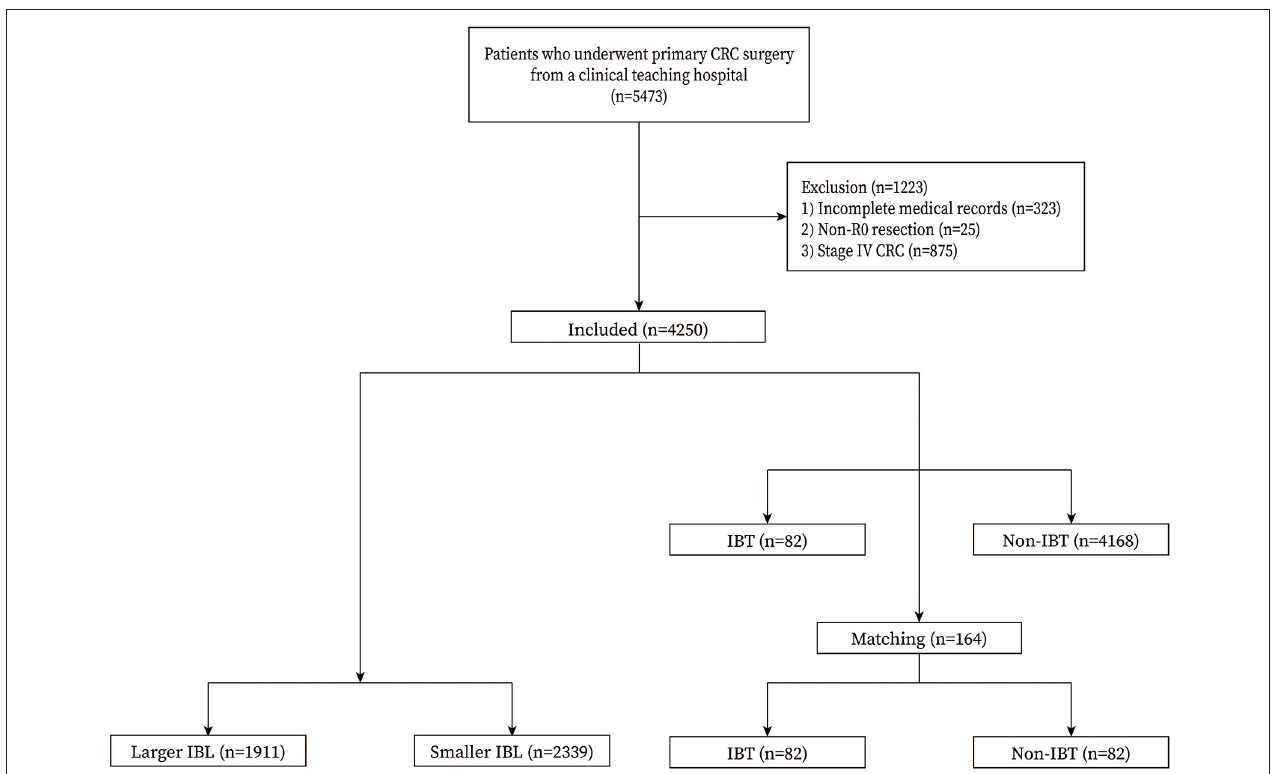
FIGURE 1 | Flow chart of patient selection. IBL, intraoperative blood loss; IBT, intraoperative blood